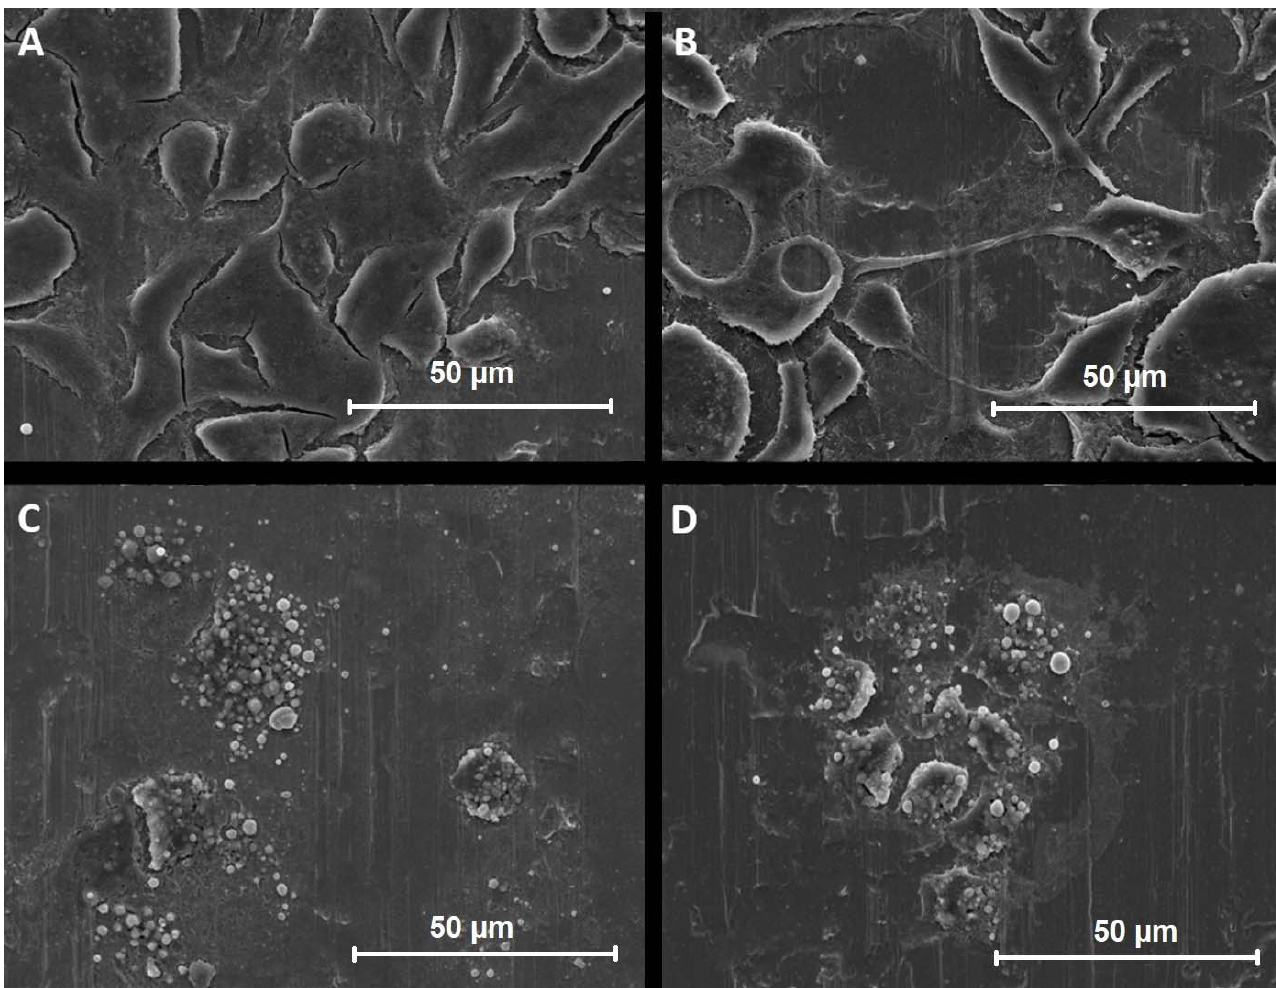
Figure 5. SEM photographs of the HepG2 cells exposed to increasing concentrations of INH at 1000× magnification. HepG2 cells were exposed to different concentrations starting with the control ( A ), 5 mM ( B ), 50 mM ( C ), and 250 mM ( D ).